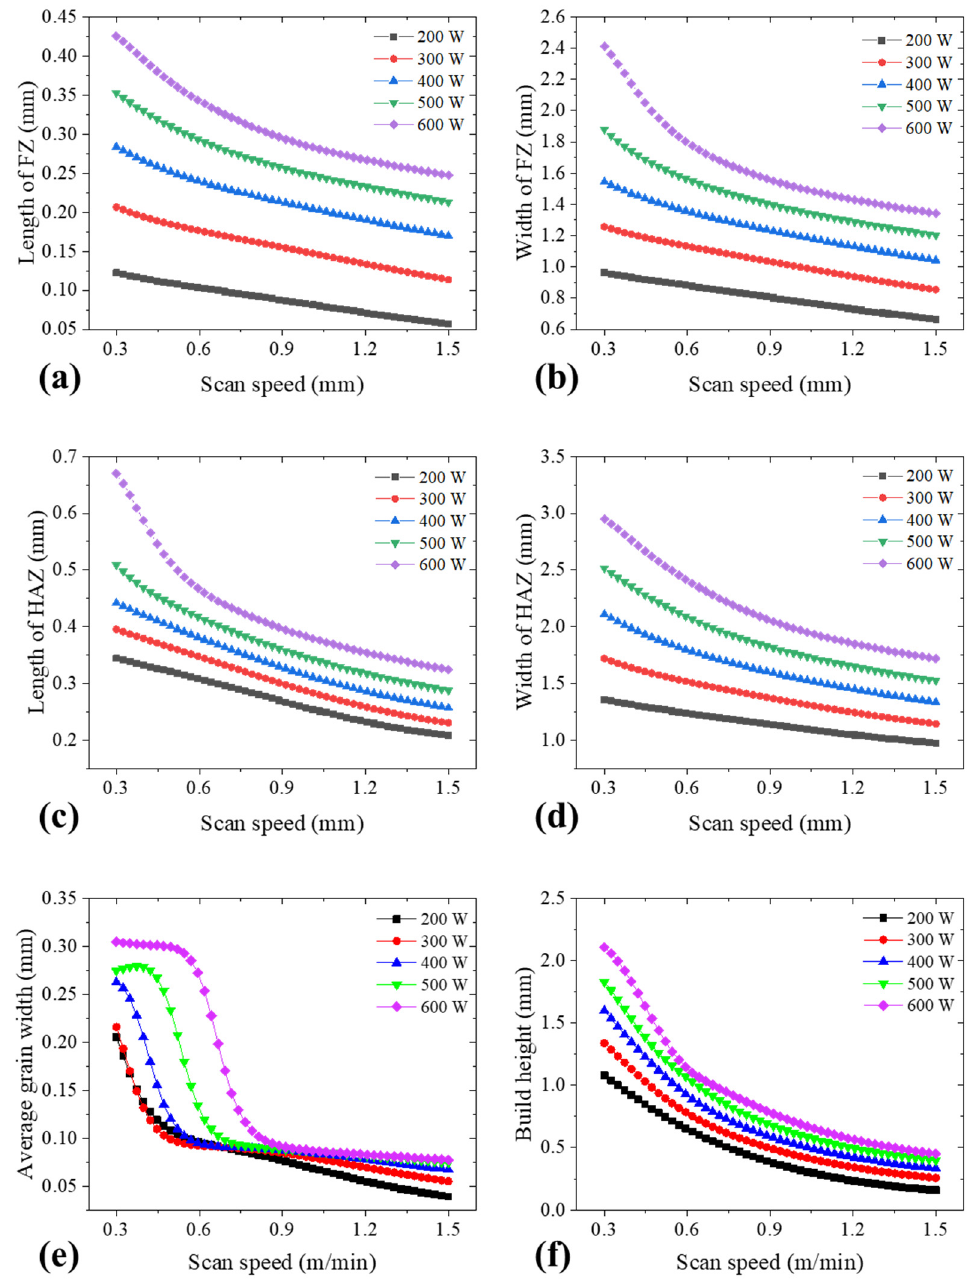
Figure 5. Estimated effect of the laser scan speed on the ( a ) length of the fusion zone (FZ), ( b ) width of the FZ, ( c ) length of the heat-affected zone (HAZ), ( d ) width of the HAZ, ( e ) columnar grain size, and ( f ) build height of the direct energy deposition-processed Ti–6Al–4V alloy components at various power levels.